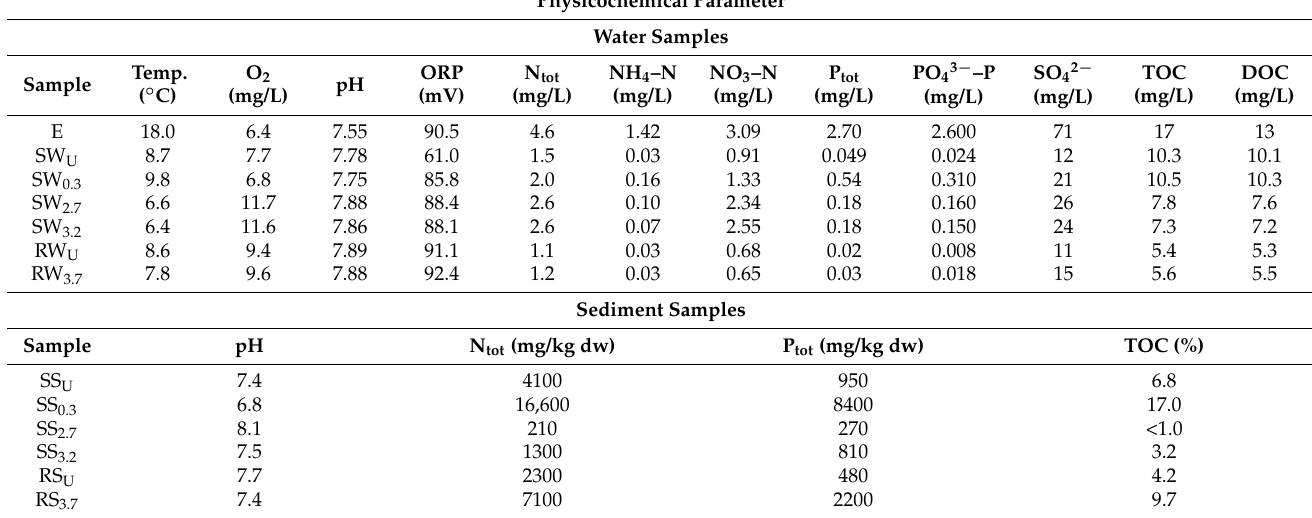
Table 1. The physicochemical parameters of the studied water and sediment samples on the main sampling day. E is the effluent of the wastewater treatment plant (WWTP), SW and RW are water samples, and SS and RS are sediment samples of the stream and river, respectively. SW U and SS U are the samples taken upstream of the WWTP discharge point, and RW U and RS U are the samples taken from the river upstream of the stream inflow point. The number in the subscript of the sample code shows the distance (km) of the sampling point downstream from the WWTP discharge point. ORP— oxidation reduction potential; N tot —total nitrogen; P tot —total phosphorus; TOC—total organic carbon; DOC—dissolved organic